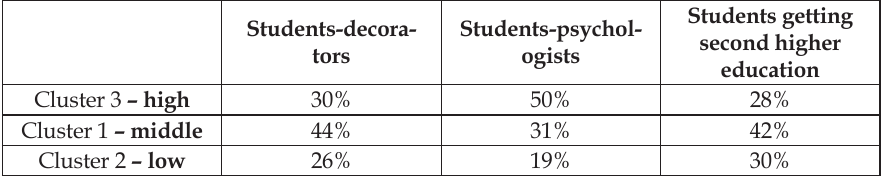
Tab. 1. Division of research participants into